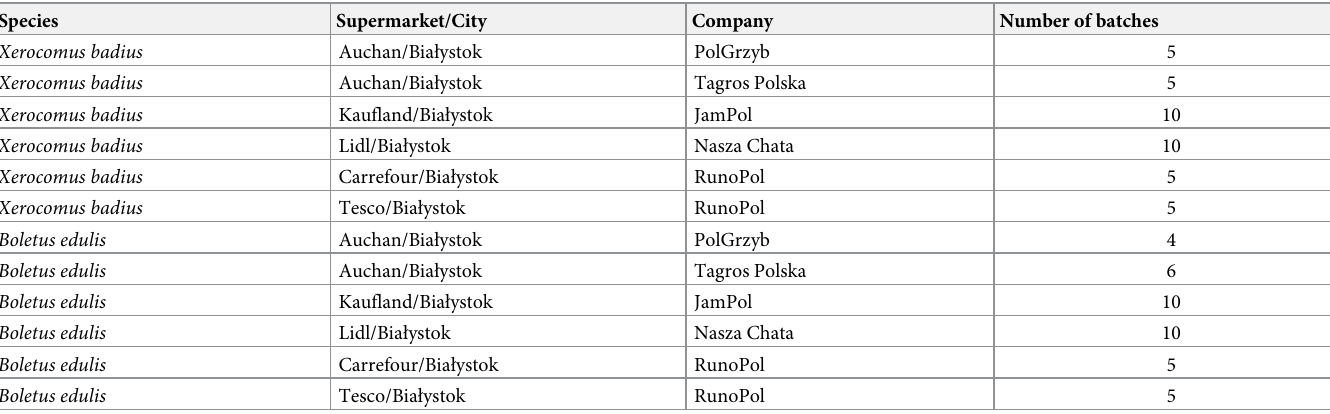
Table 1. Characteristics of studied samples of